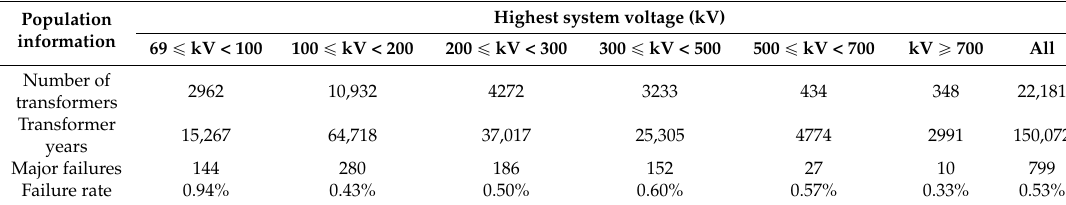
Table 2 . Investigated population and failure rates of substation transformers [4]. Table 2. Investigated population and failure rates of substation transformers [4].